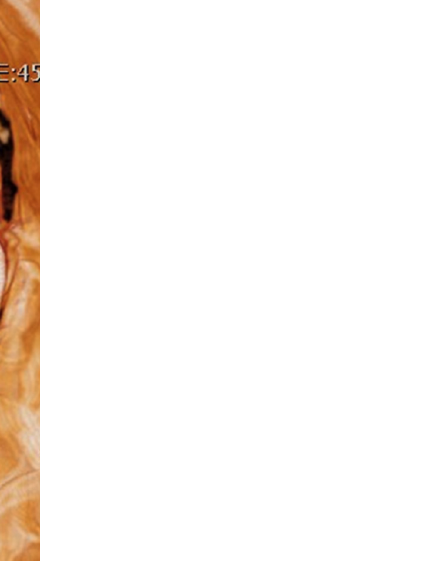
Fig 13. IND 50: Lace on the neck of the blouse